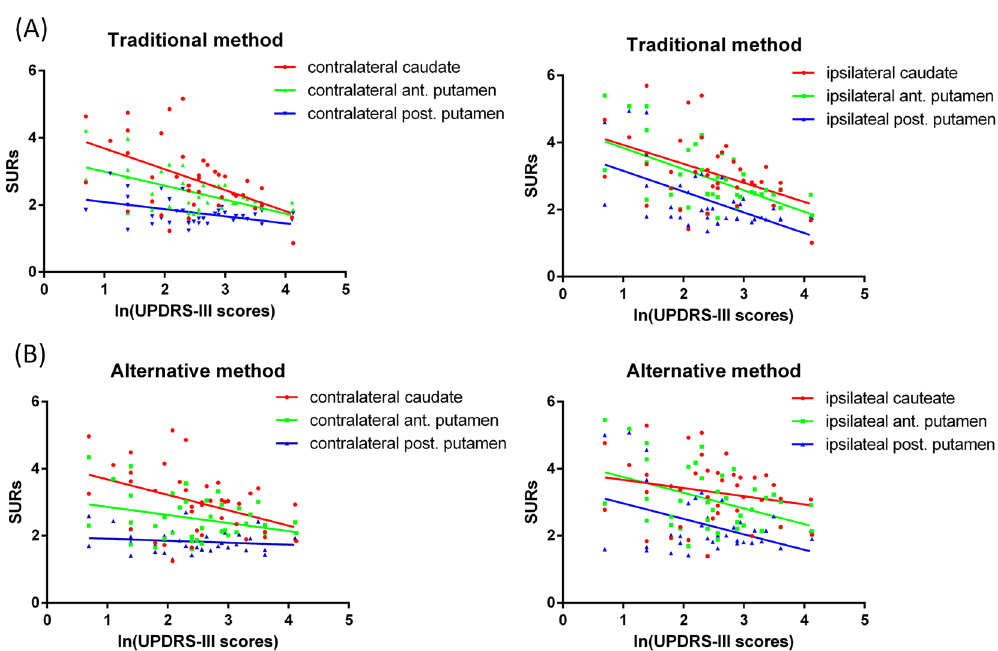
Figure 4. Correlations between log-transformed UPDRS-III scores and SURs in the caudate, anterior and posterior putaminal regions derived from the traditional ( A ) and alternative ( B )